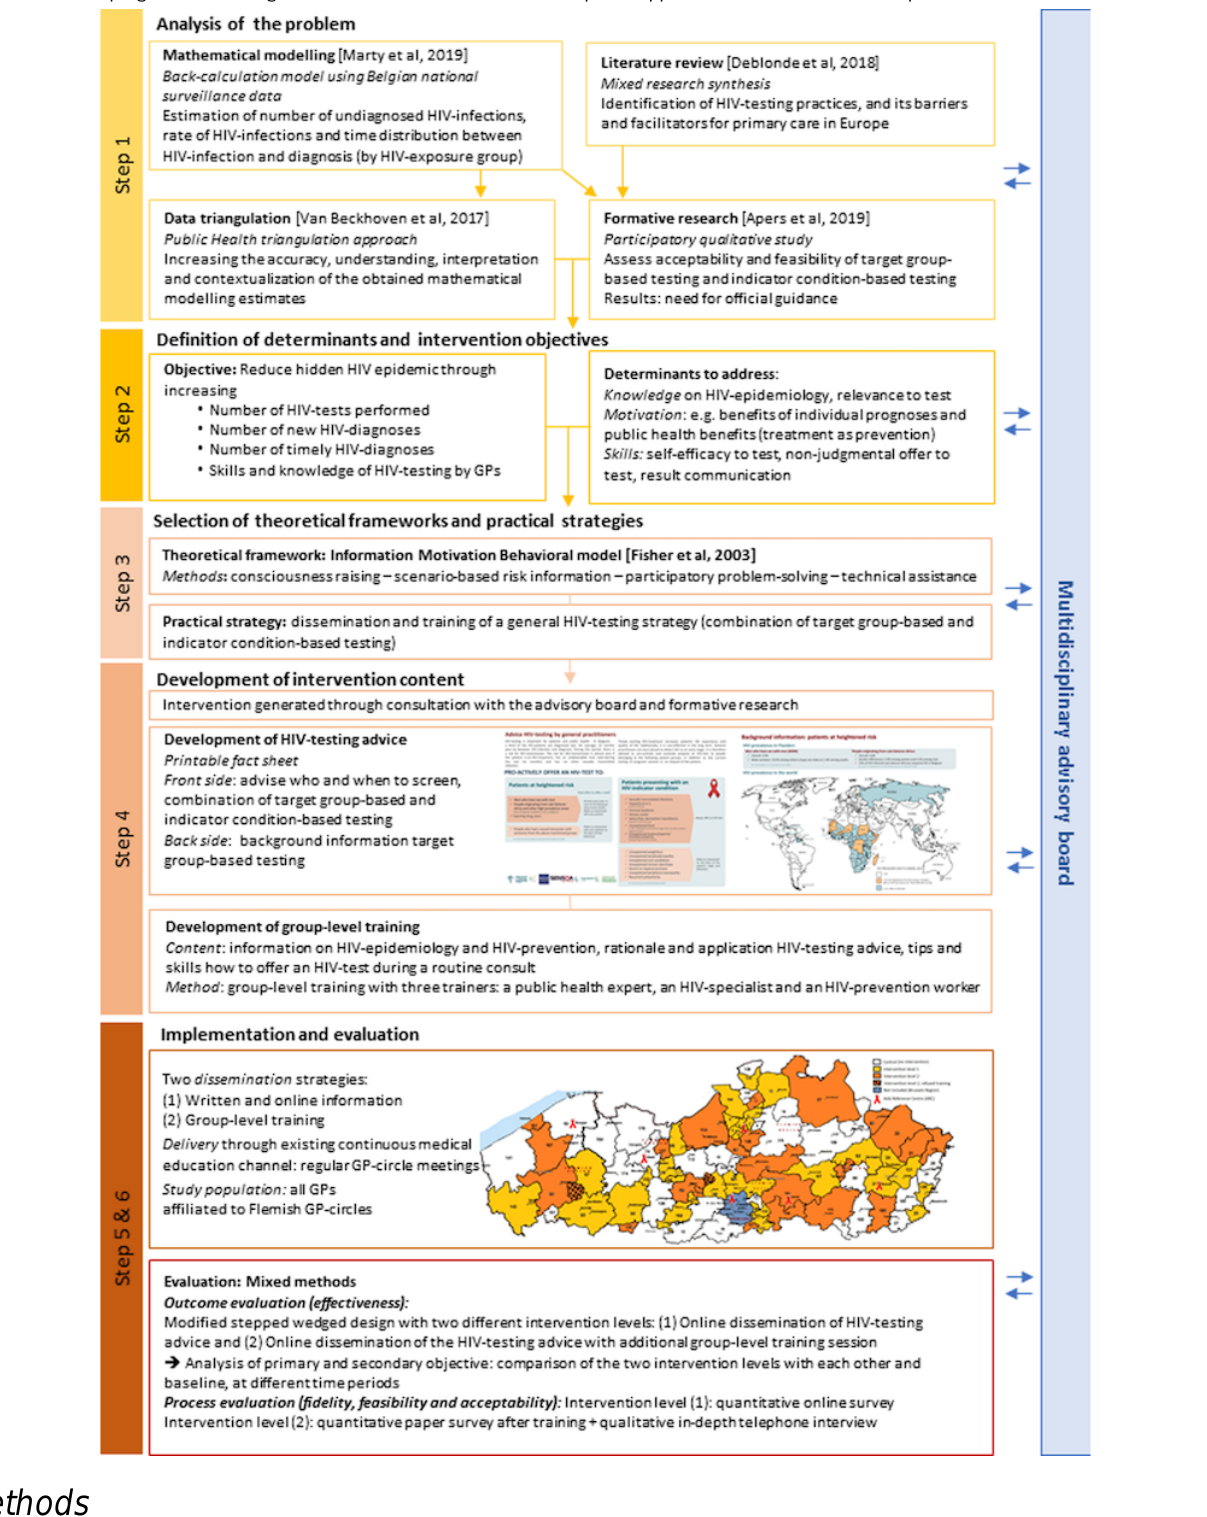
Figure 1. Developing an HIV-testing intervention for Flemish GPs. A stepwise approach to intervention development